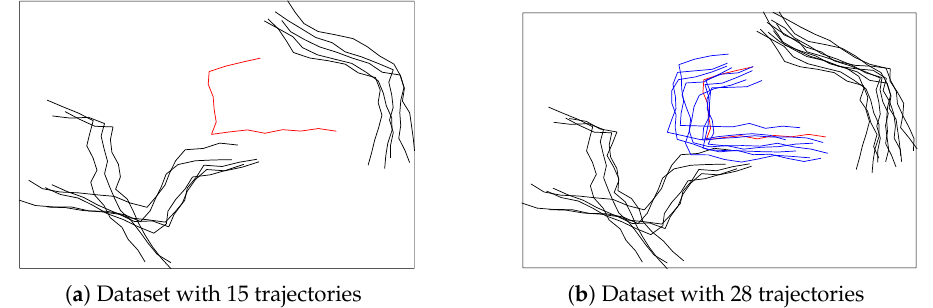
Figure 1. Plots of the trajectory change in dataset. As time goes on, from ( a ) to ( b ), the number of trajectories increases, and the red trajectory has several similar items (in blue